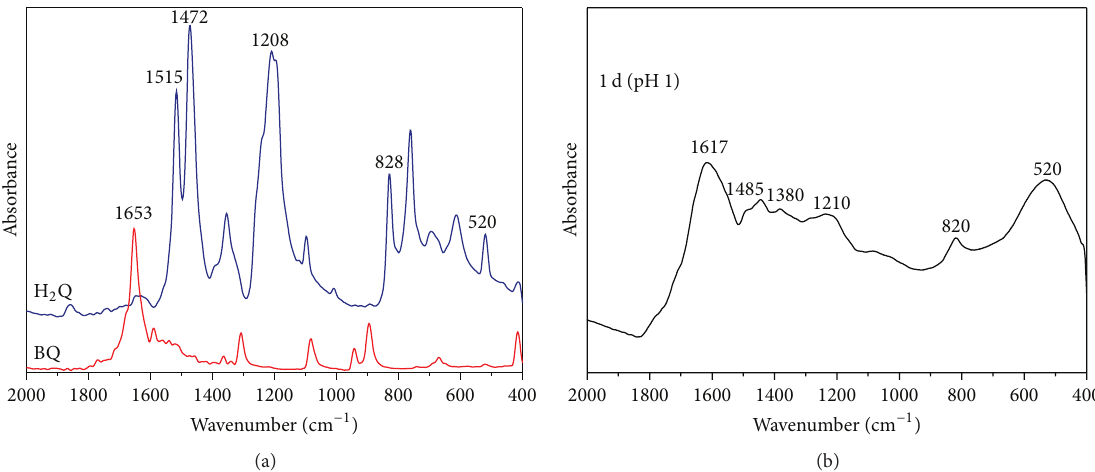
Figure 6: FT-IR spectra of (a) the standard H 2 Q and BQ samples and (b) the acidized precipitates (1d (pH